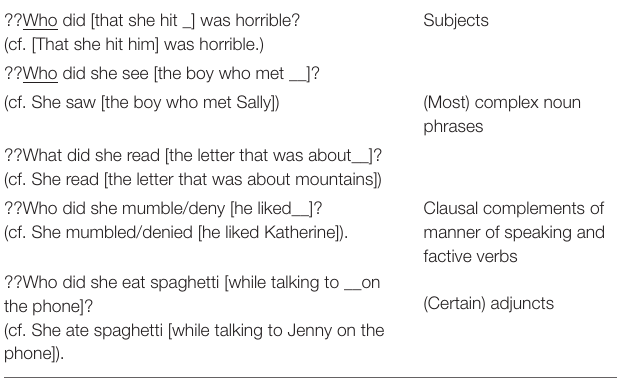
TABLE 3 | Examples of island constructions: constructions that resist containing the gap in a LDD (Ross, 1967). ??Who did [that she hit _] was horrible? (cf. [That she hit him] was